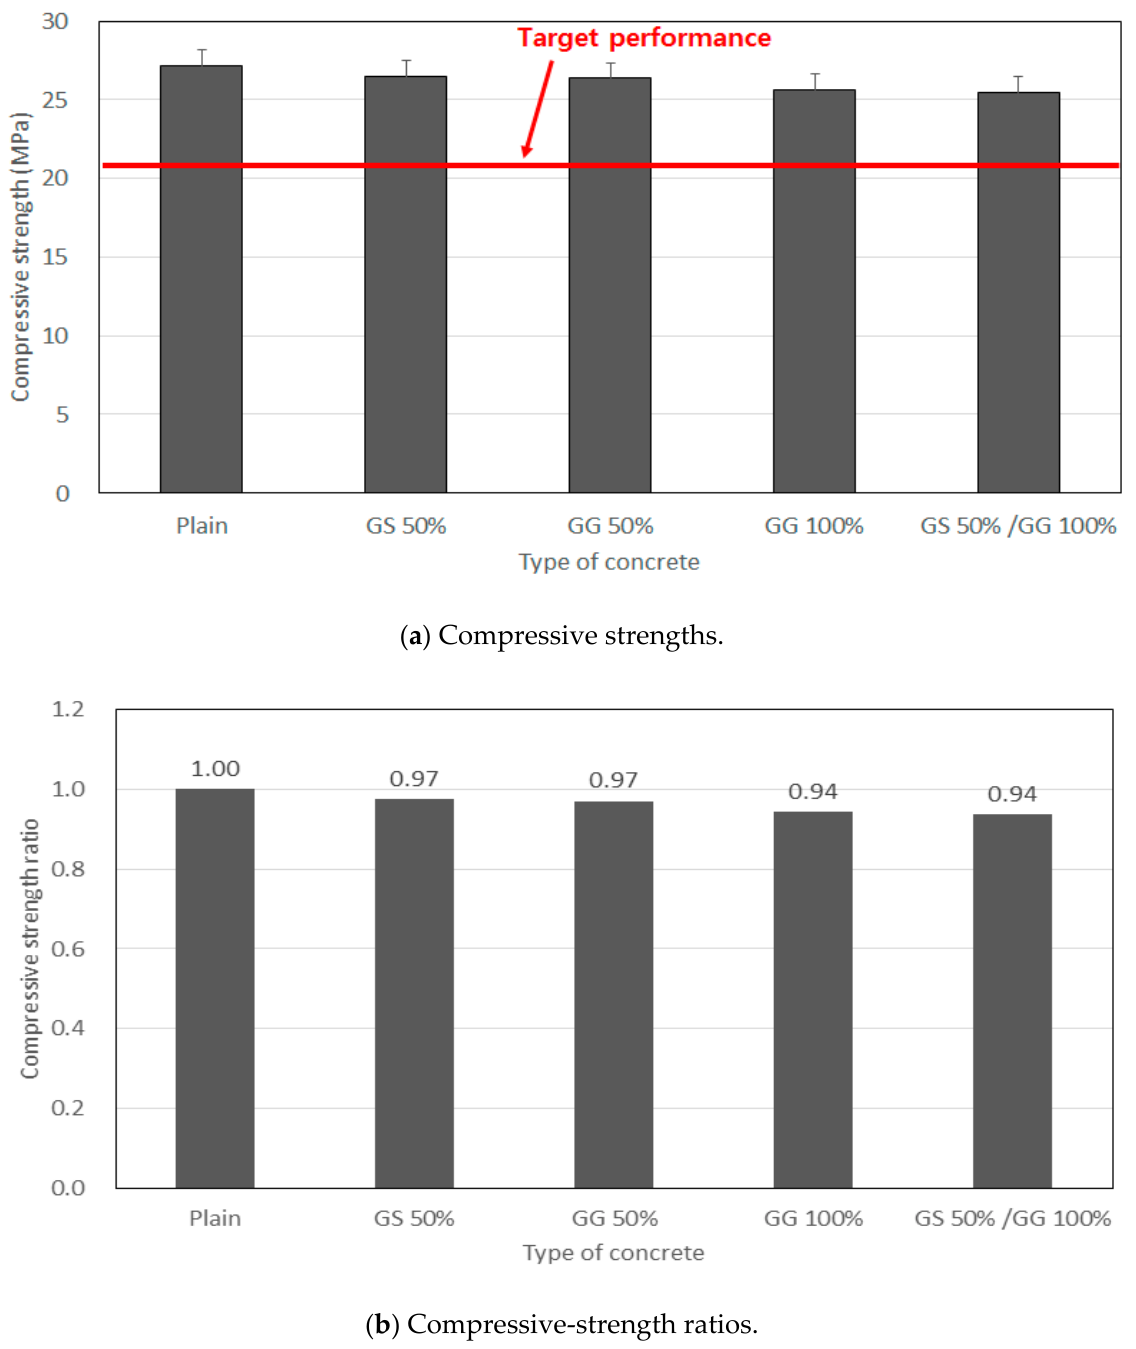
Figure 4. Test results for compressive strength.